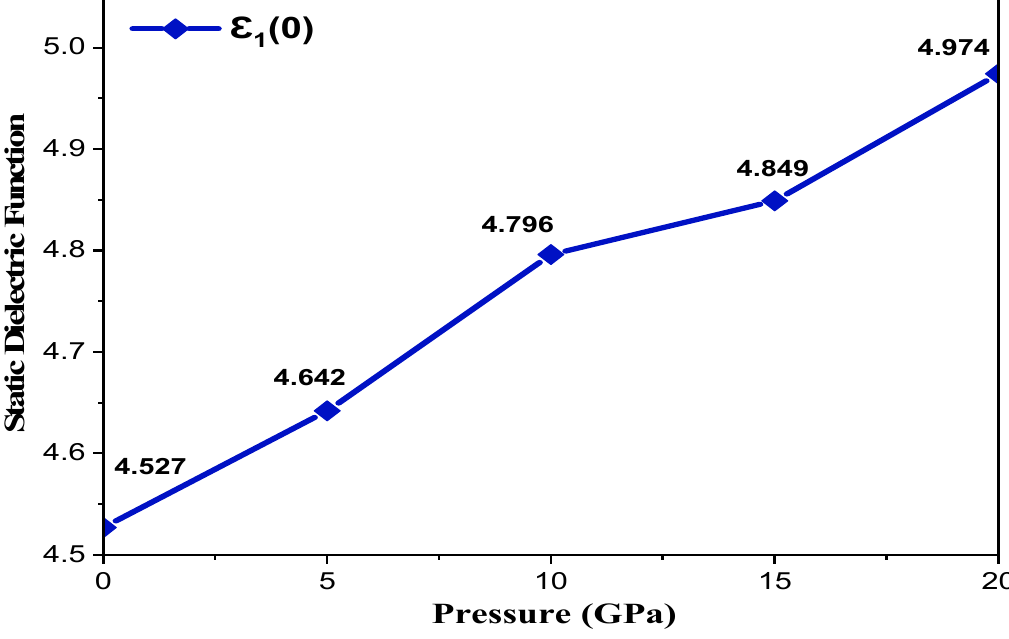
Figure 5. Pressure-induced variations in the static dielectric function.